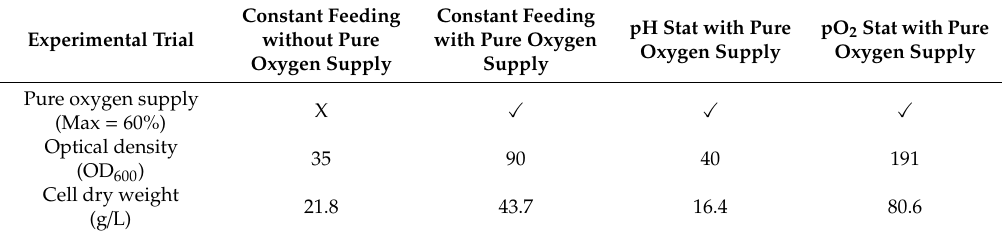
Figure 2. Fermentation optimization in terms of cell dry weight. Growth profile of Bacillus caldovelox arginase mutant (BCA-M) fermentation using constant feeding without pure oxygen supply, constant feeding with pure oxygen supply, pH stat with pure oxygen supply and pO2 stat with pure oxygen supply. Table 1. Comparison of the highest cell dry weight and optical density produced by different feeding strategies.